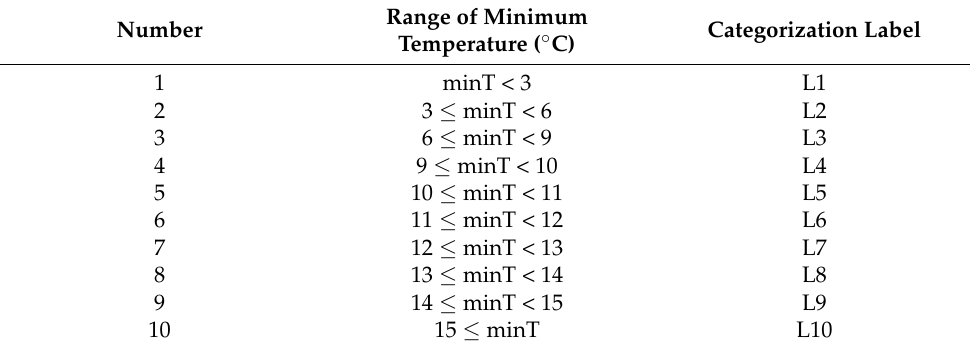
Table 4. Classification of minimum temperature (minT).